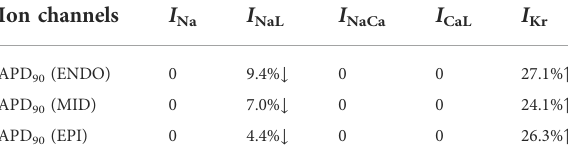
TABLE 5 Effects of ranolazine-induced changes in single ion channels on APD 90 .